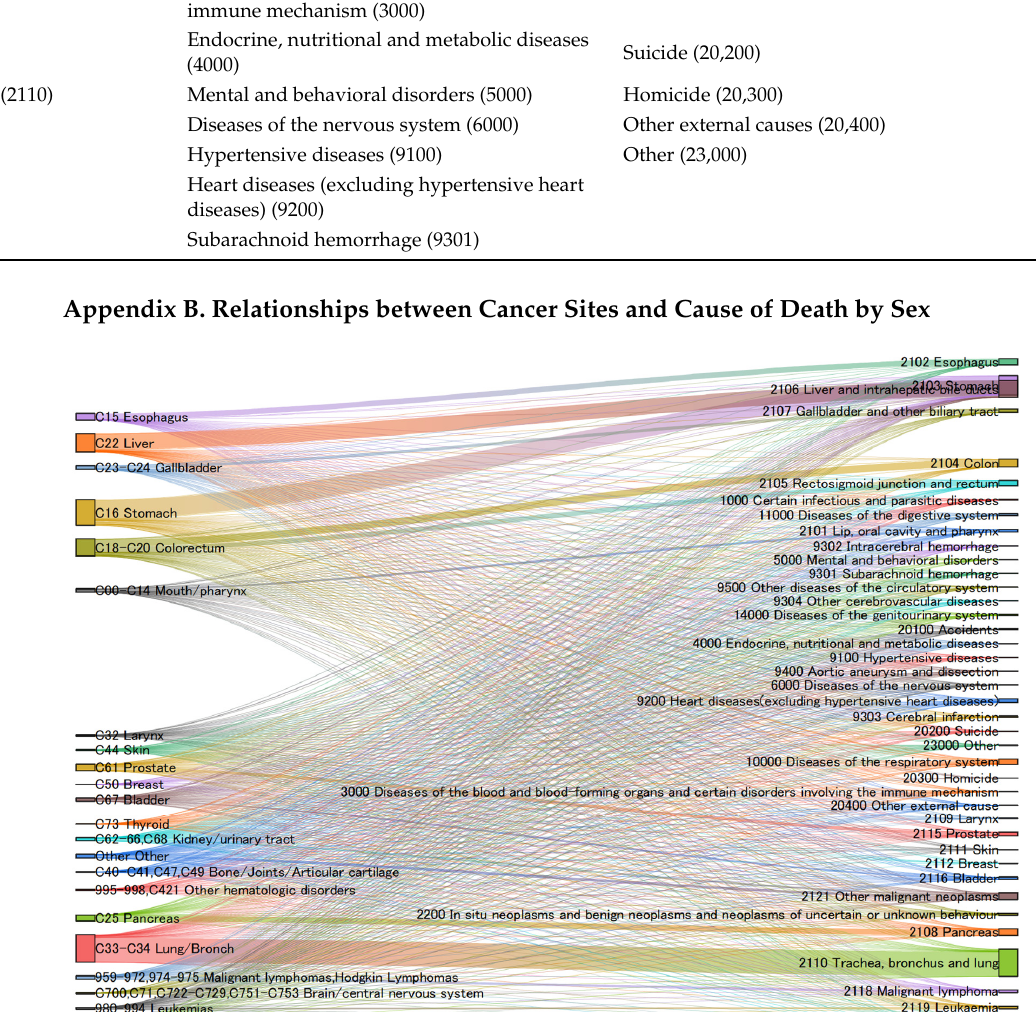
Figure A2. Relationships between cancer sites and cause of death (female patients).